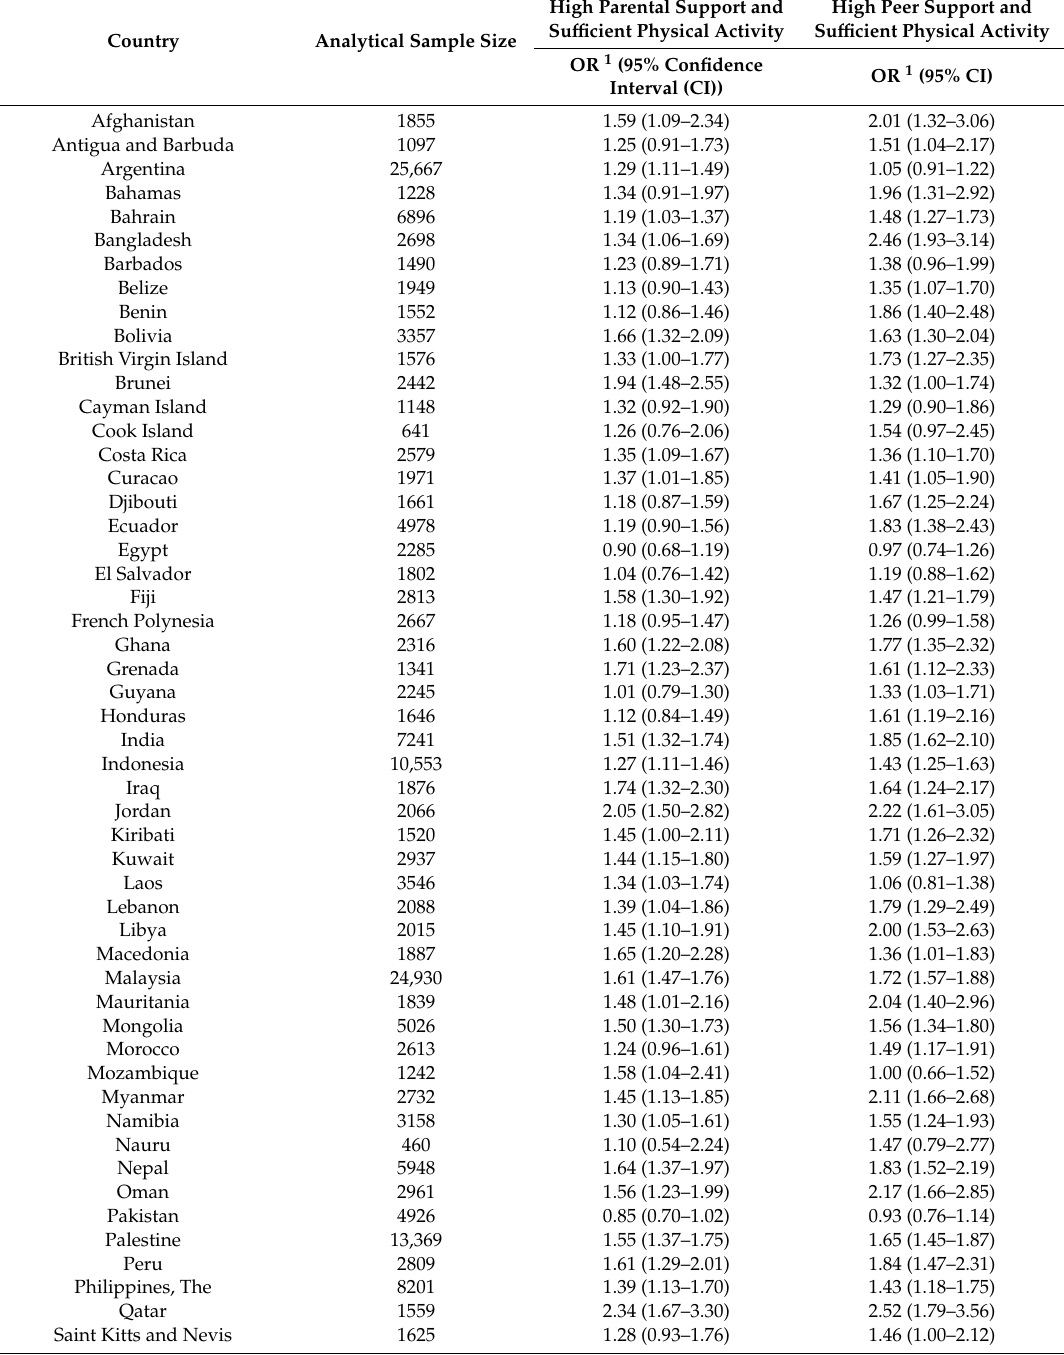
Table 1. Country-level adjusted odds ratios (ORs) of parental and peer support with su ffi cient levels of physical activity among adolescents aged 11–17 years, Global School-based Student Health Survey,